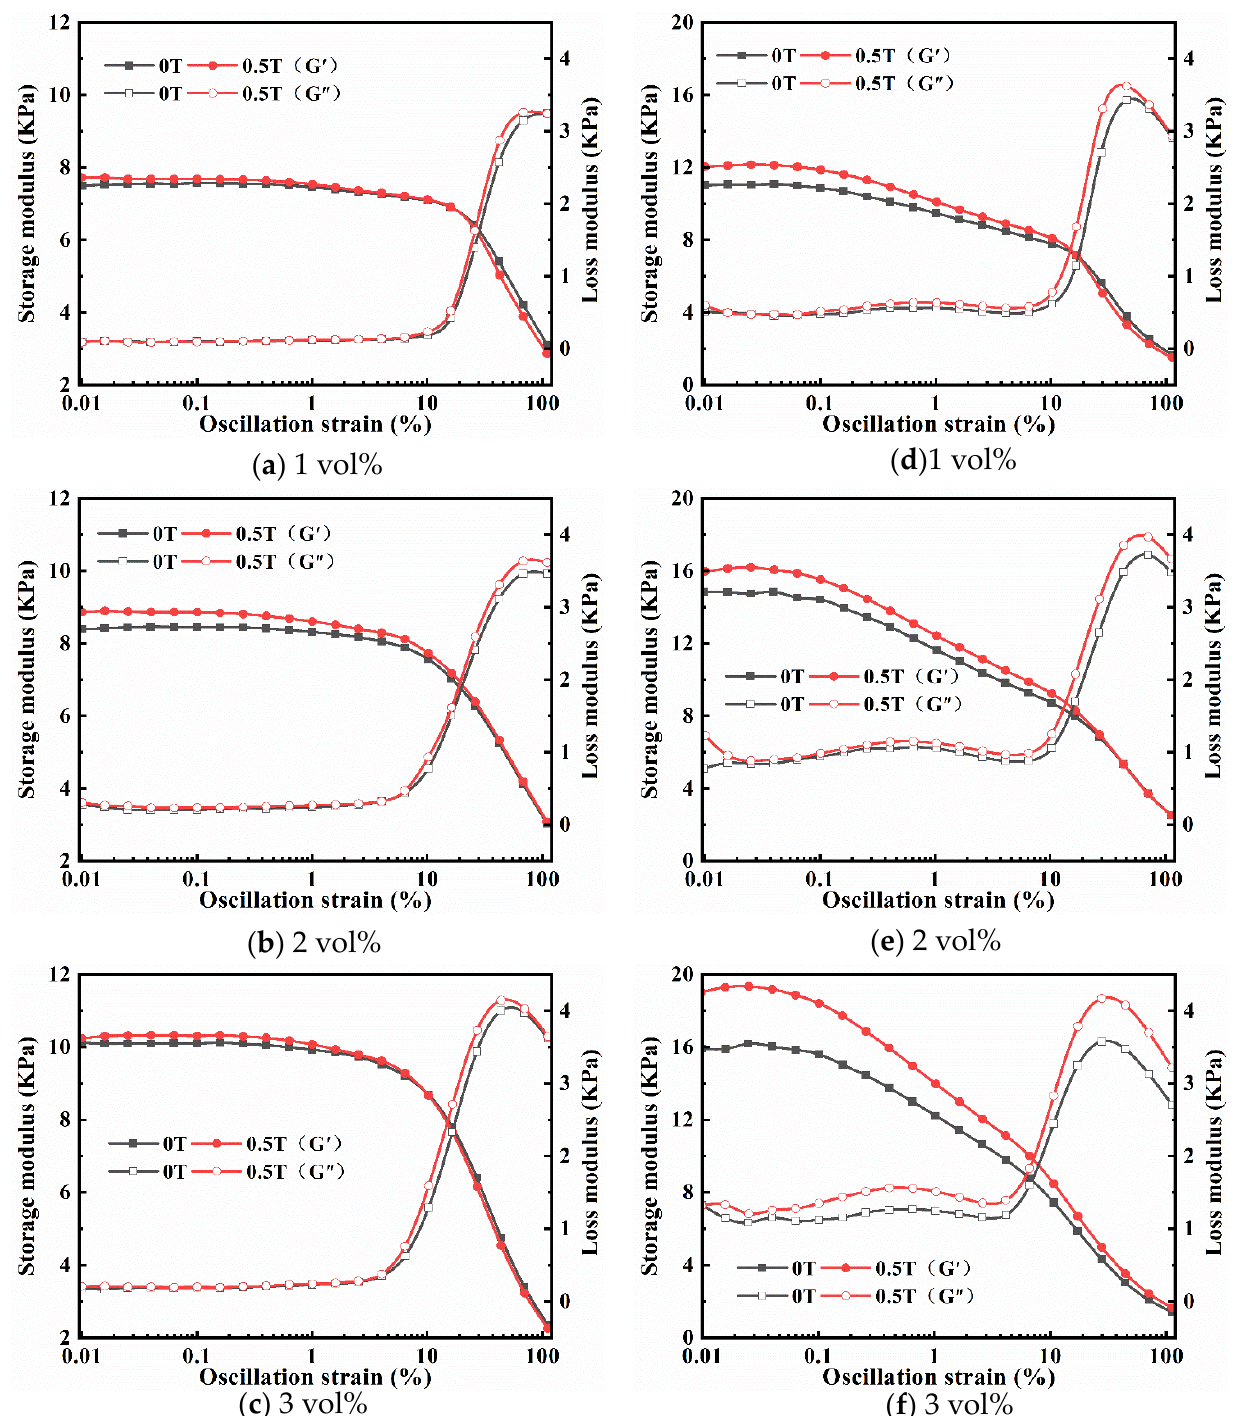
Figure 3. Strain amplitude dependence of the G (cid:48) and G (cid:48)(cid:48) of isotropy ( a – c ) and anisotropy ( d – f ) samples with Fe 3 O 4 of 1 vol%, 2 vol% and 3 vol% under 0 T and 0.5 T at a fixed frequency of 10